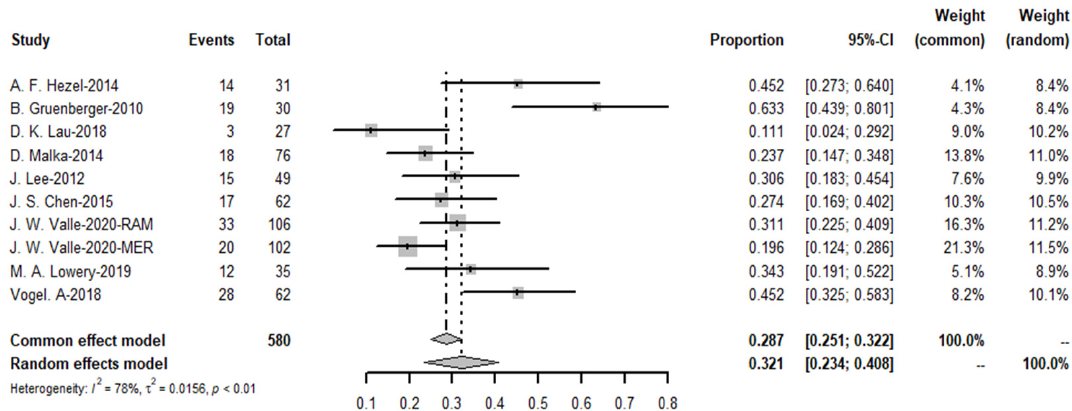
Figure 19. Objective response rate of targeted therapies.